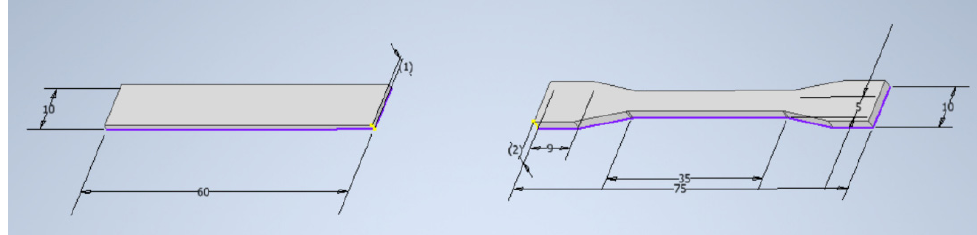
Figure 2. The dimensions of the samples— a bar and a paddle, respectively.